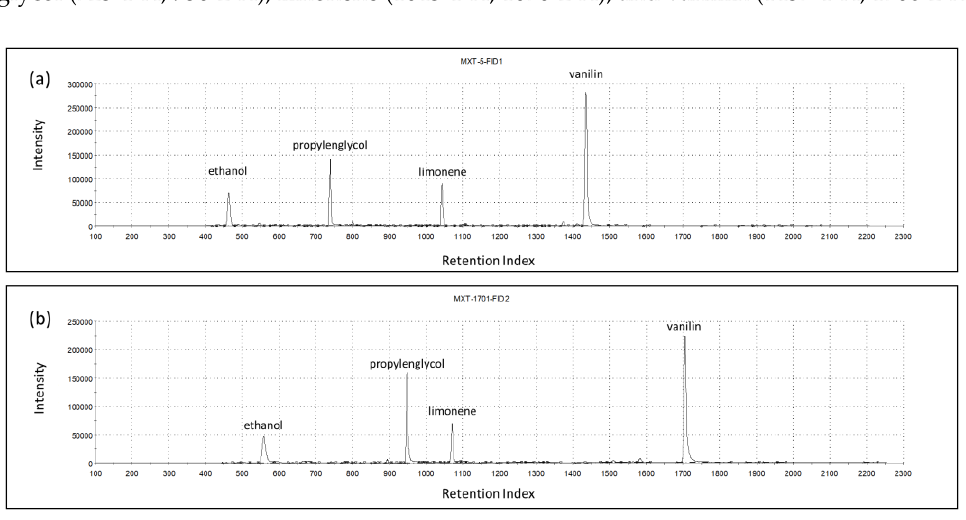
Figure 2. Chromatograms of columns MXT-5 ( a ) and MXT-1701 ( b ) for one vanilla shake sample, indicating the most prominent volatiles.